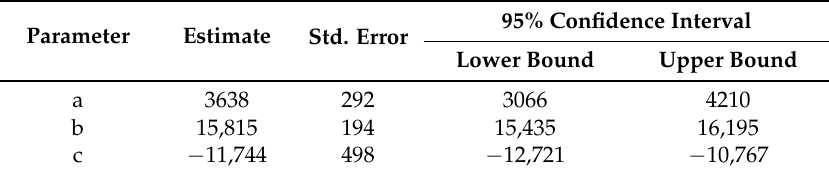
Table D1. Model 1 estimated coefficients (non-linear